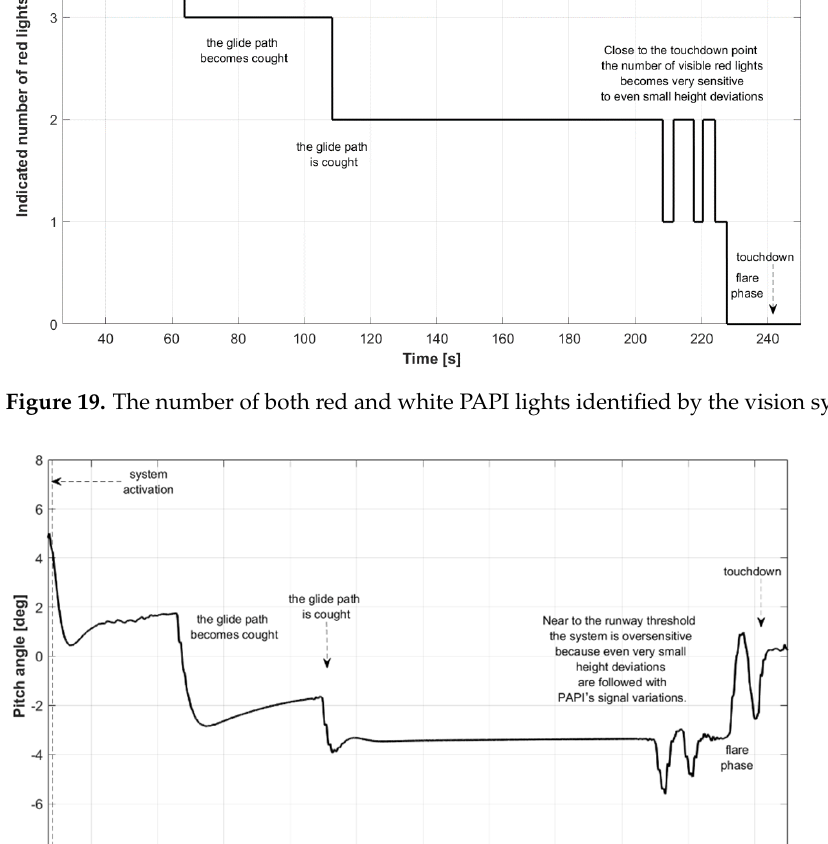
Figure 20. The pitch angle commanded by the automatic landing system, as maintained by the autopilot.